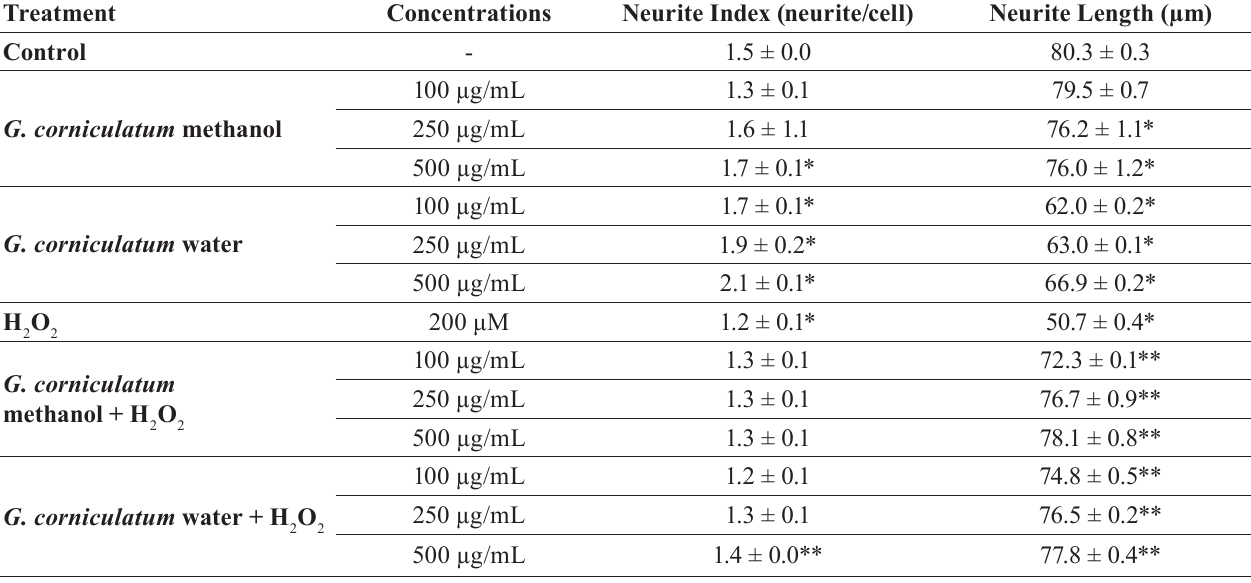
TABLE I - E ffects of H O and G. corniculatum methanol and water extracts on neurite index and neurite length in dPC12 2 2